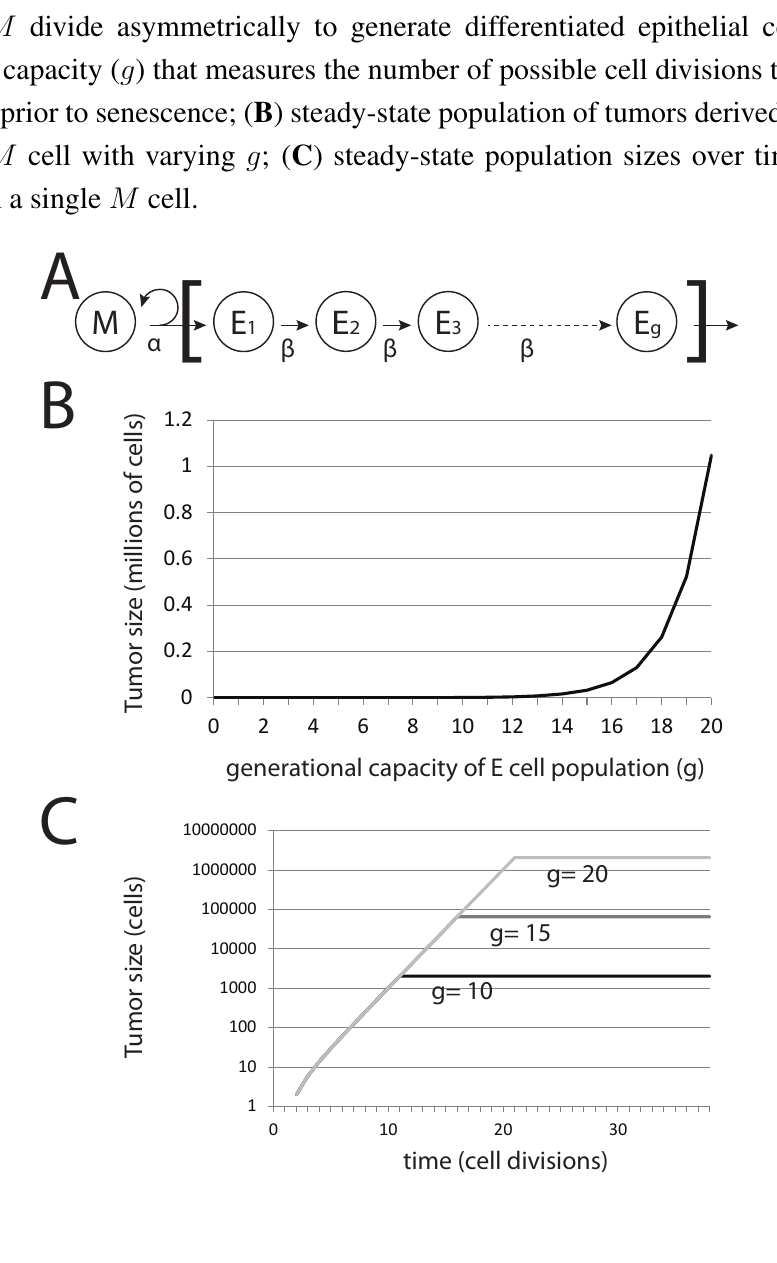
Figure 6. Generational capacity affects dormant tumor steady-state population sizes in a stochastic